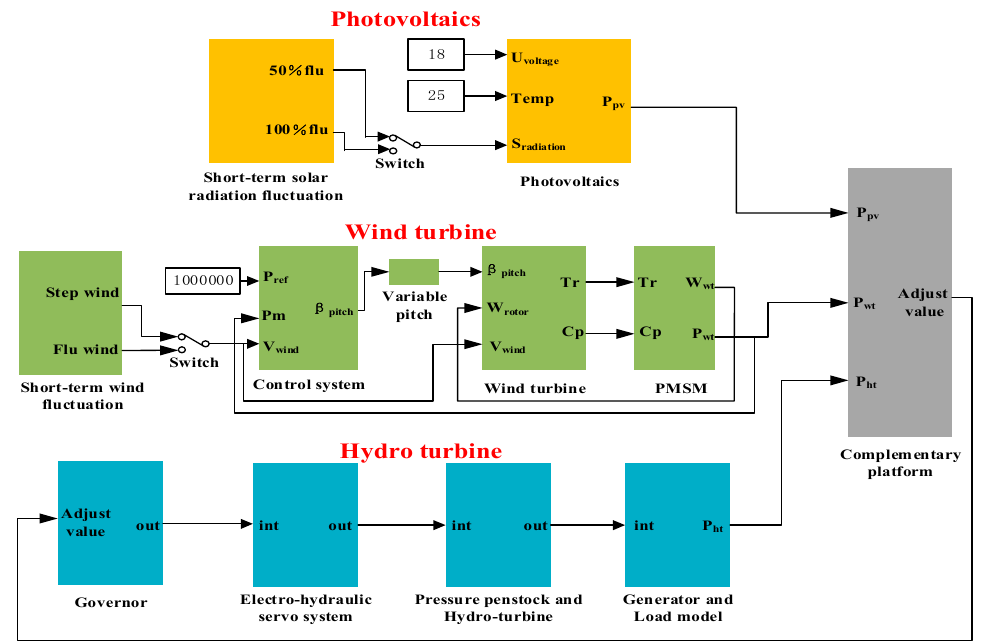
Figure 1. Hybrid system model.